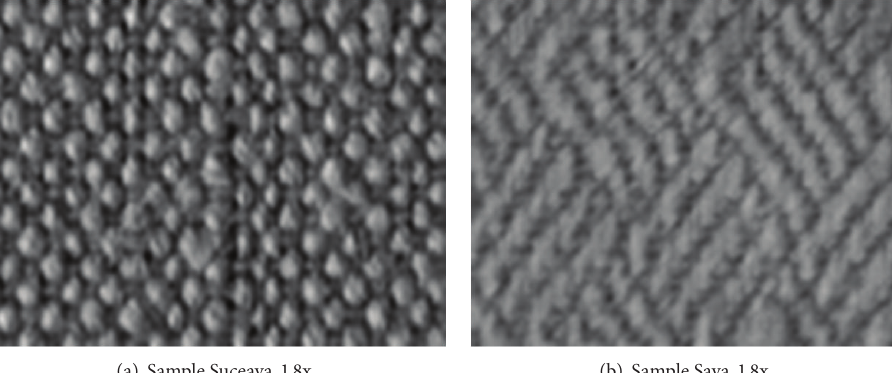
Figure 4: Images of weaves from hemp.